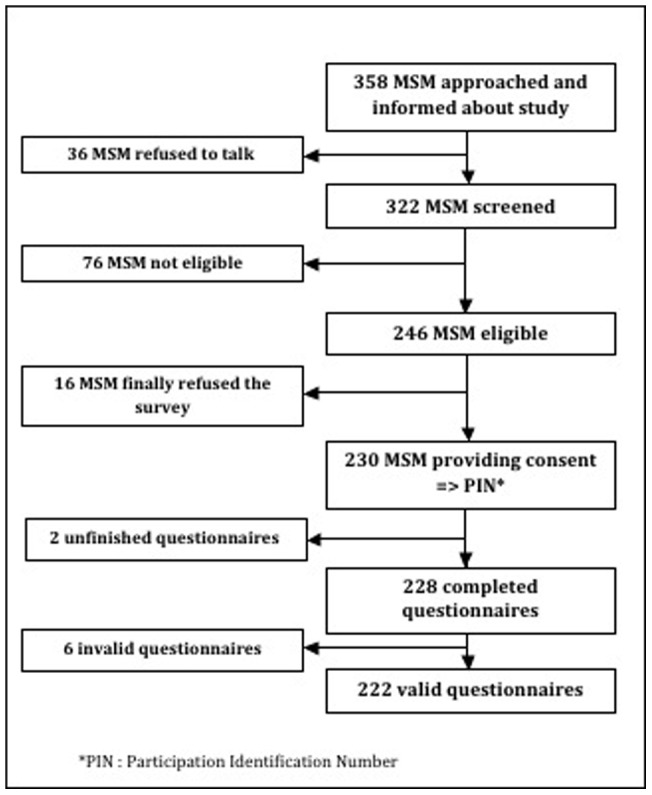
Flow chart of data collection among men who have sex with men.